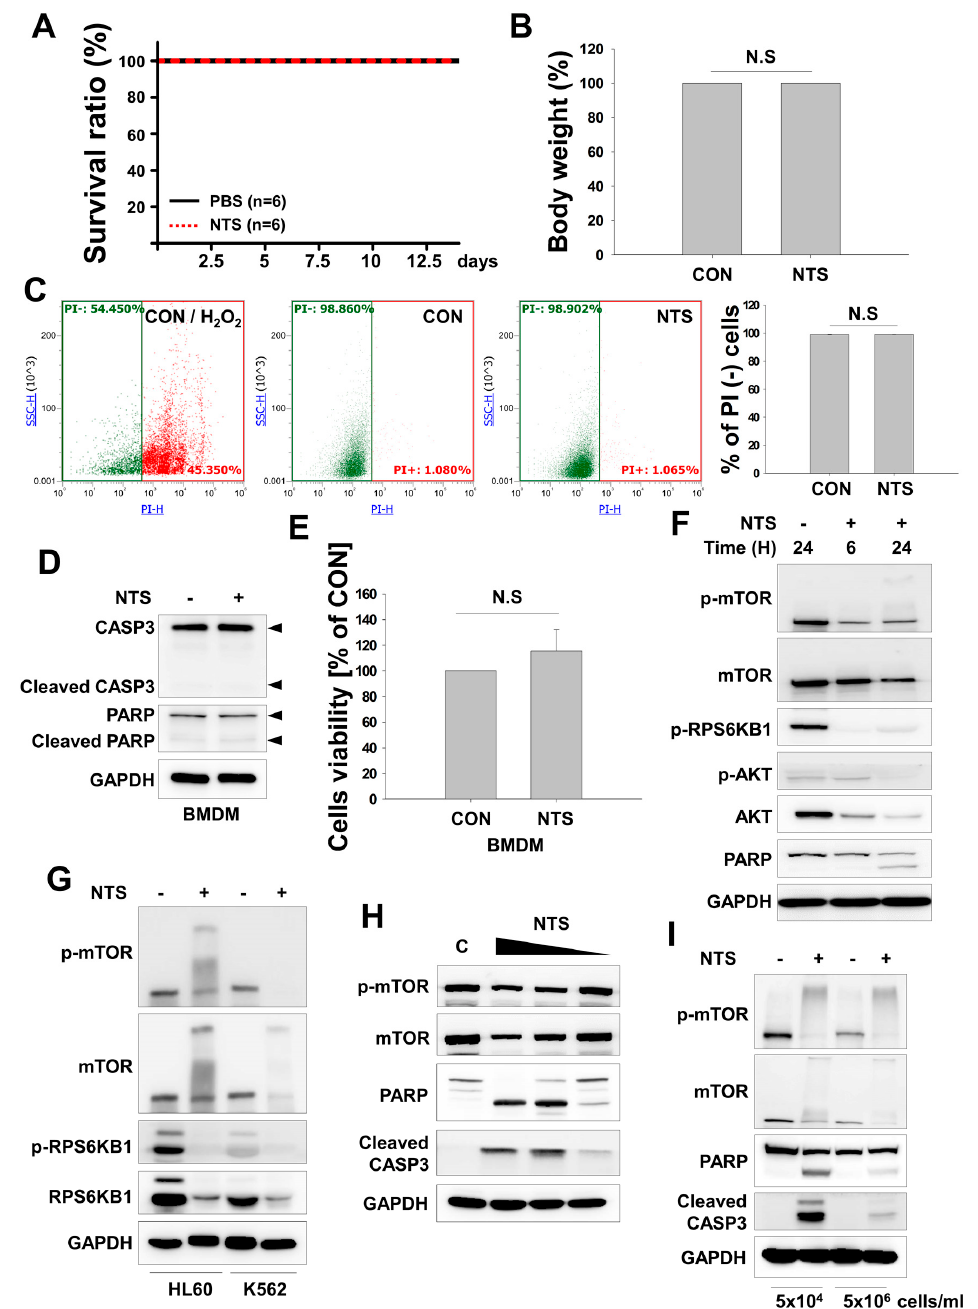
Figure 2. NTS induces downregulation of mechanistic target of rapamycin (mTOR) without acute side e ff ects. ( A , B ) NTS was given to mice by IV injection (200 µ L) once daily for 2 weeks and acute death ( A ) or loss of body weight ( B ) were monitored. ( C ) FACS analysis of NTS-induced cytotoxicity in peripheral blood mononuclear cells (PBMCs) isolated from control or NTS-treated mice (n = 6). Data are means ± SD. ( D , E ) NTS does not induce cell death in mouse bone marrow-derived macrophages (BMDM). ( F ) mTOR expression in KG-1 cells treated with NTS as evaluated by Western blot. ( G ) Western blot analysis of mTOR expression and ubiquitination in NTS-treated HL60 or K562 cells. Ubiquitination is seen as smearing and appearance of the band at a high molecular weight. ( H ) The antileukemic e ff ects of NTS were reduced in a concentration-dependent manner. NTS was serially diluted in serum-free media and used to treat for 24 hours. Protein levels were determined by the indicated antibodies. ( I ) NTS a ff ects the viability of leukemia cells not only in low but also in high cell densities. K562 cells were treated with NTS for 24 hours. Proteins level was evaluated by Western